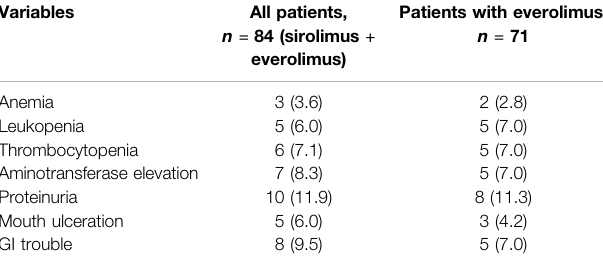
TABLE 2 | Adverse events by mTOR inhibitor use (within 2 months). Variables All patients, n = 84 (sirolimus + everolimus)